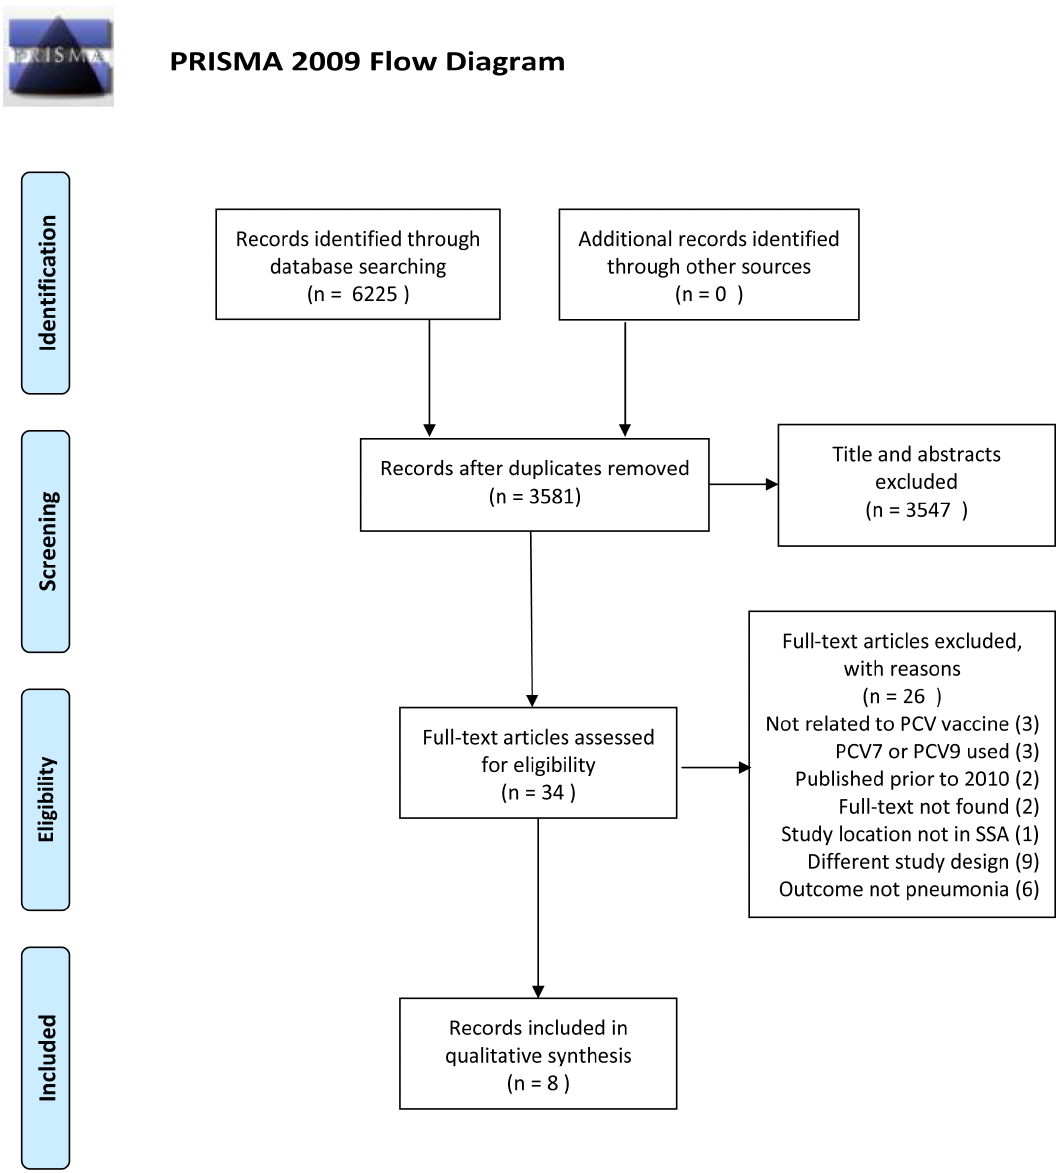
Figure 1. PRISMA flow diagram showing review selection